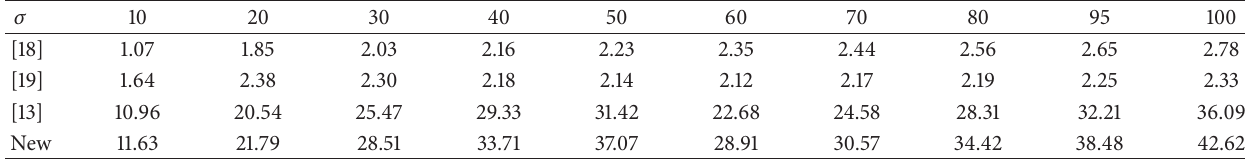
Table 7: IEF of different algorithms with different Gaussian noise levels for Salesman video sequence.